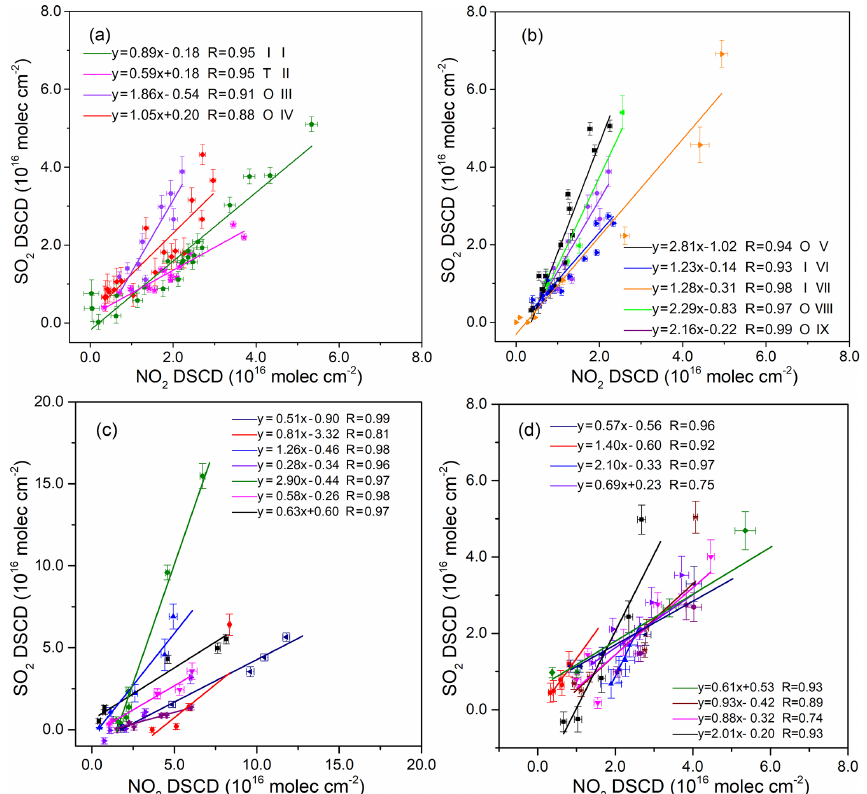
Figure 13. The relationship between SO 2 and NO 2 emitted by several typical vessels.”O” indicates outbound vessels, ”I” indicates inbound vessels and ”T” indicates tugboats.